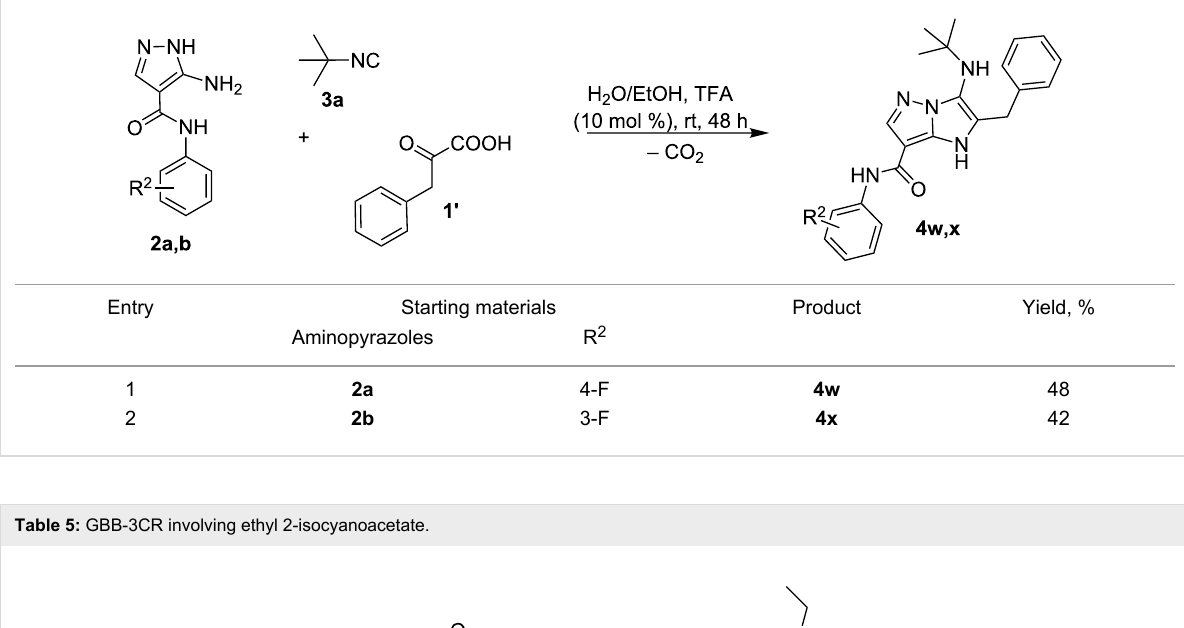
Table 4: Phenylpyruvic acid in GBB-3CR.